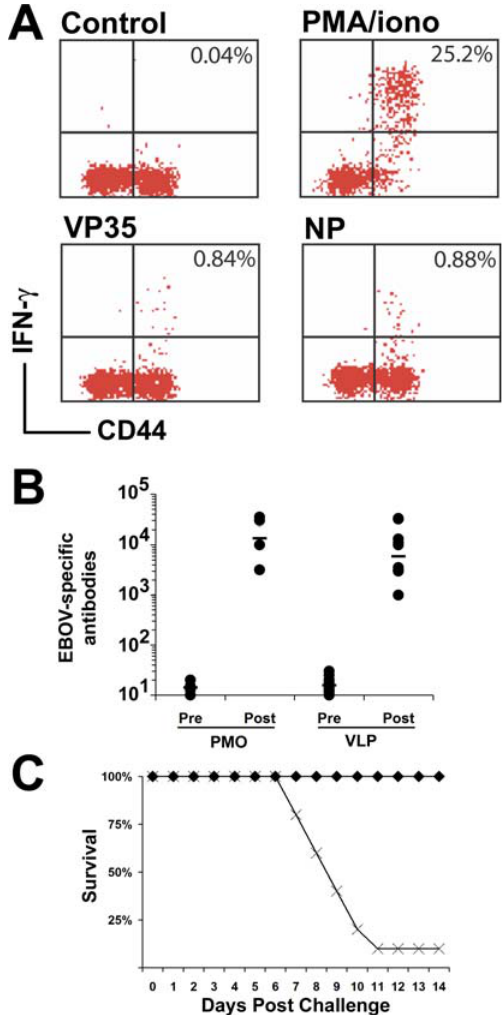
Figure 4. Immune Responses of PMO-Treated Mice Following Survival of Ebola Virus Infection (A) PMO-treated C57BL/6 mice that have previously survived EBOV infection generate EBOV-specific CD8 þ responses. Pooled splenocytes from three PMO-treated EBOV survivors were restimulated in vitro with EBOV-specific VP35 or NP peptides, an irrelevant Lassa NP peptide as a negative control, or PMA/ionomycin as a positive control. The stimulated cells were stained after for 4 h in culture with anti-CD44-FITC, anti-IFN- c - PE, and anti-CD8-Cy-Chrome. The percent of CD44 þ , IFN- c þ cells among CD8 þ lymphocytes is indicated in the upper right quadrant of each plot. These data are representative of several experiments examining the EBOV-specific T cell epitopes in PMO-treated mice after challenge. (B) Total serum anti-EBOV antibodies were measured in surviving mice prior to or 4 wk following treatment and challenge. PMO mice were treated with the combination of PMOs 24 hand 4 h before challenge, and their antibody responses are compared with mice treated with Ebola VLPs 24 h before EBOV infection. The results are depicted as the endpoint titers of the individual mice (filled circles). The horizontal line in each column represents the geometric mean titer of the group. (C) Mice that previously survived EBOV challenge following PMO treatment were rechallenged with 1,000 pfu of mouse-adapted Ebola virus 4 wk after the initial challenge. Results are plotted as percent survival forthePMO-treatedmice(black)andnaı¨vecontrolmice( n ¼ 10pergroup). DOI: responses of the surviving monkeys. By 28 d after EBOV challenge, the surviving rhesus monkeys had high levels of both anti-EBOV antibodies and T cell responses, similar to the PMO-protected mice (unpublished data).